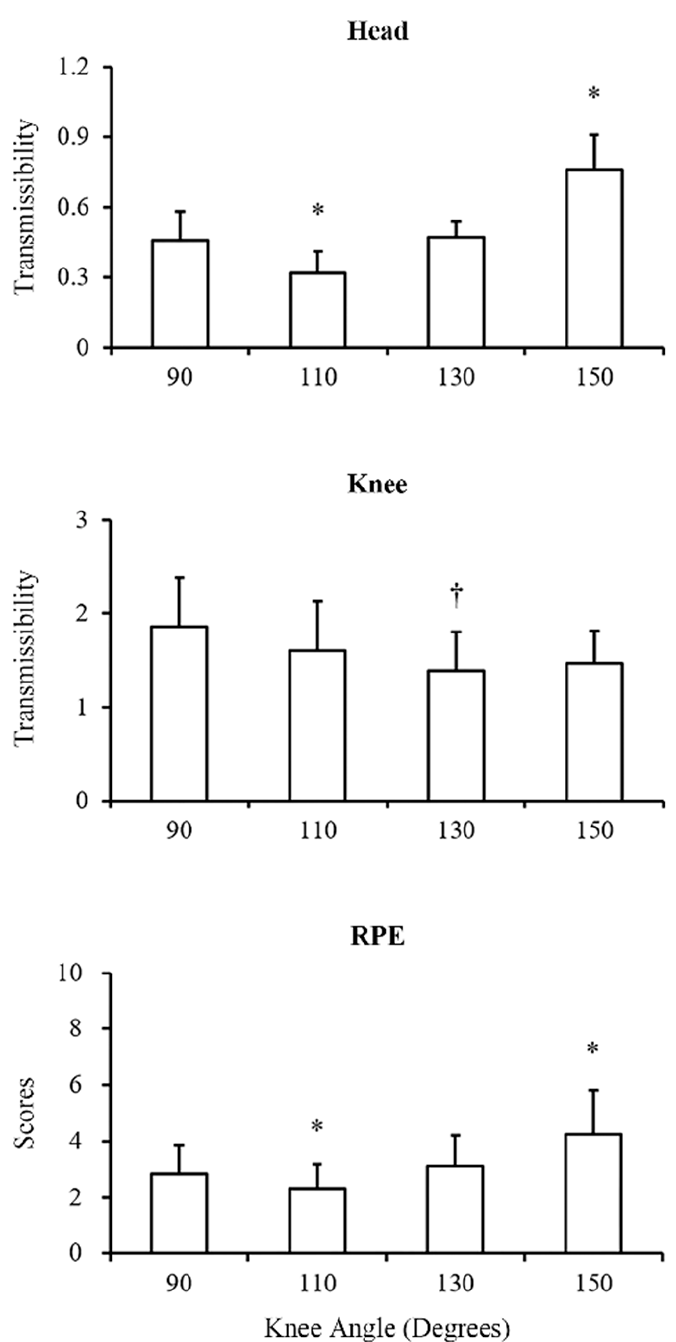
Figure 2. Comparison of the head transmissibility, knee transmissibility, and rating of perceived exertion (RPE) among different knee angle conditions. Data are expressed as mean ± SD. * Represents significant difference with other conditions ( p < 0.01). † Represents significant difference with the knee flexion angle of 90 degrees condition ( p < 0.01).